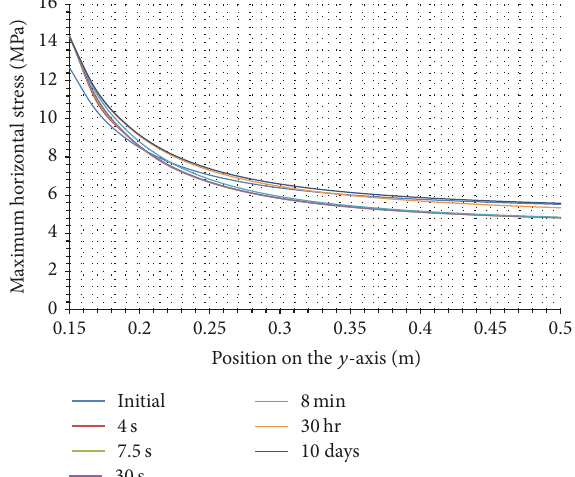
Figure 12: 𝑌 -component of maximum horizontal stresses as a function of time in poroelastic medium with 𝜎 𝐻 = 16.8MPa and 𝜎 ℎ = 14 MPa, 𝑃 𝑟 = 11MPa, 𝑃 𝑤 = 9.7 MPa, 𝑘 𝑥 = 0.01md, 𝑘 𝑦 = 0.01 md, and 𝑇 𝑚 = 330 K.